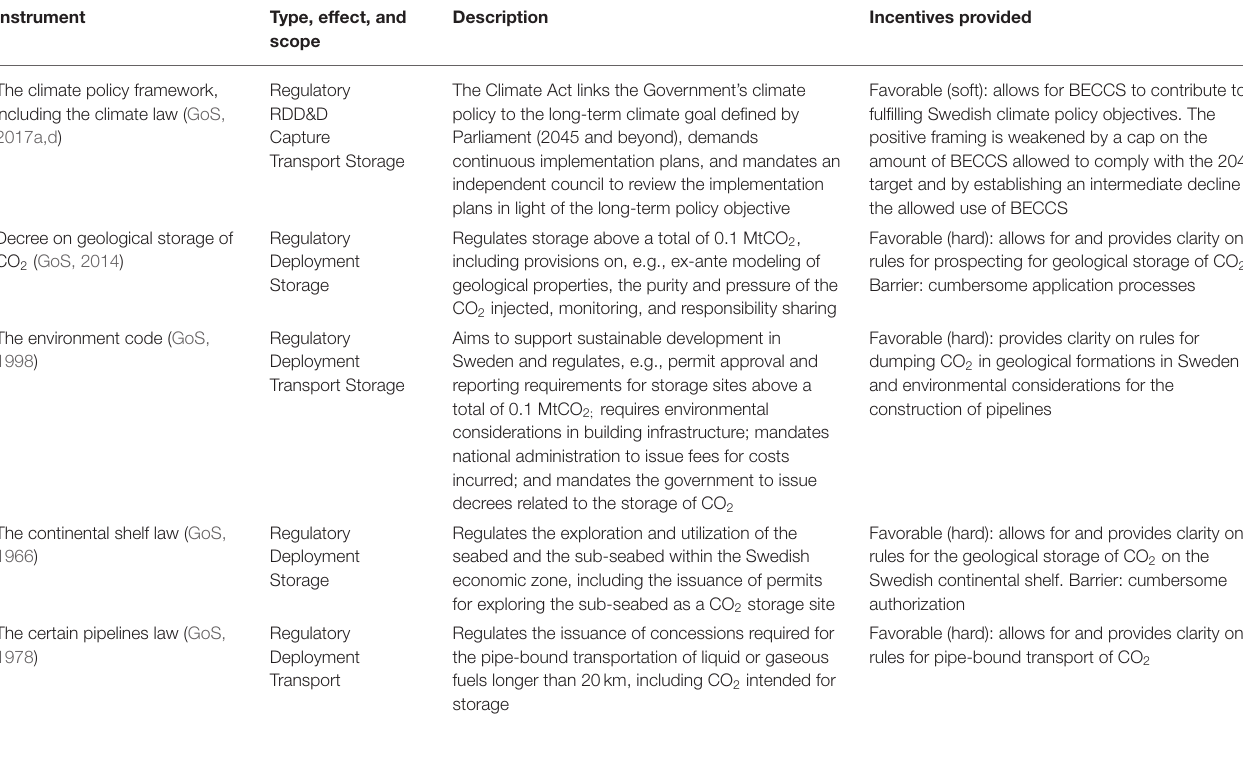
TABLE 7 | National (Swedish) regulatory and informational policy instruments of direct relevance to BECCS RDD&D, in descending order of significance.